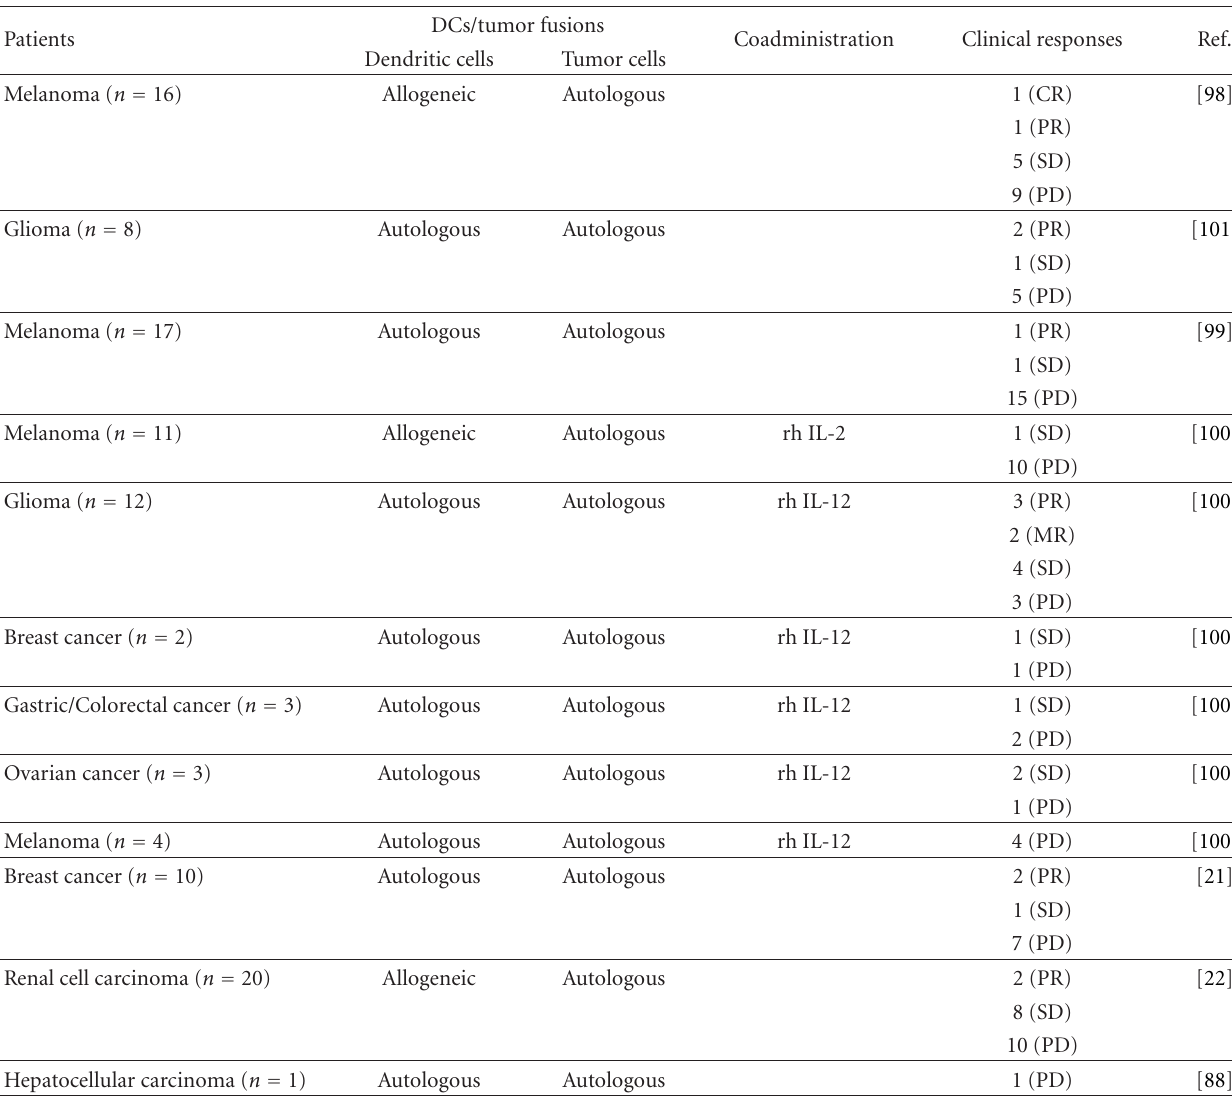
Table 1: Assessment of DCs/tumor fusions based